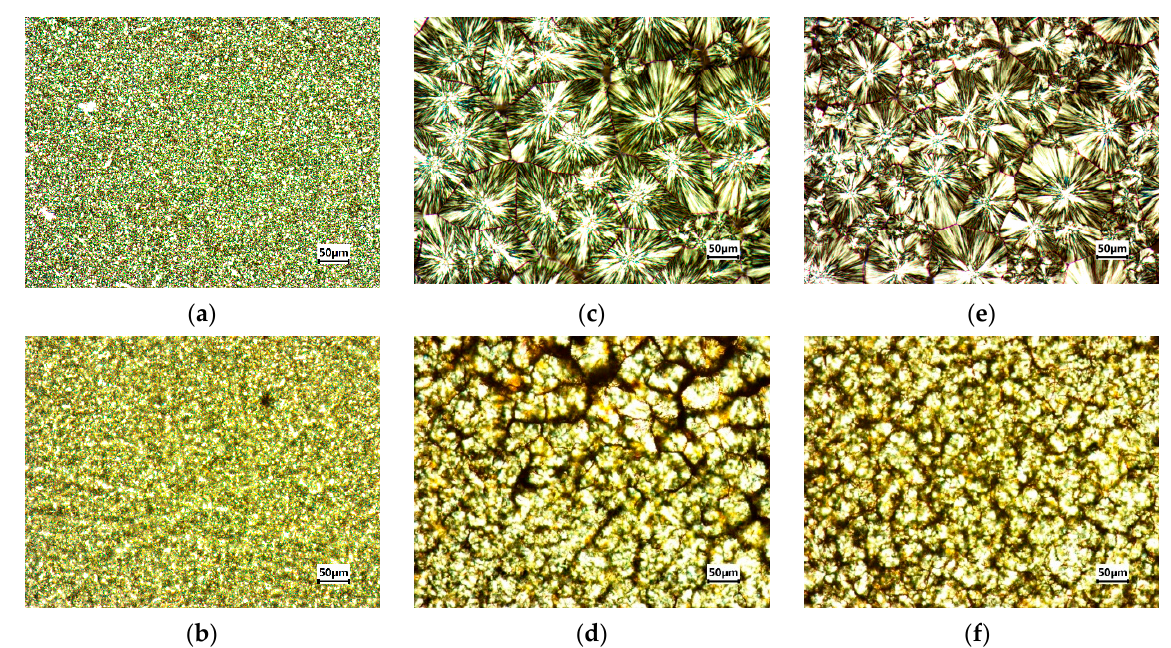
Figure 11. Microscopic observations of PP pure and PP/MWCNTs with 0.1 wt.% of MWCNTs for fast ‐ cooling treatment ( a , b ); isothermal treatment ( c , d ); and slow ‐ cooling treatment ( e , f ).